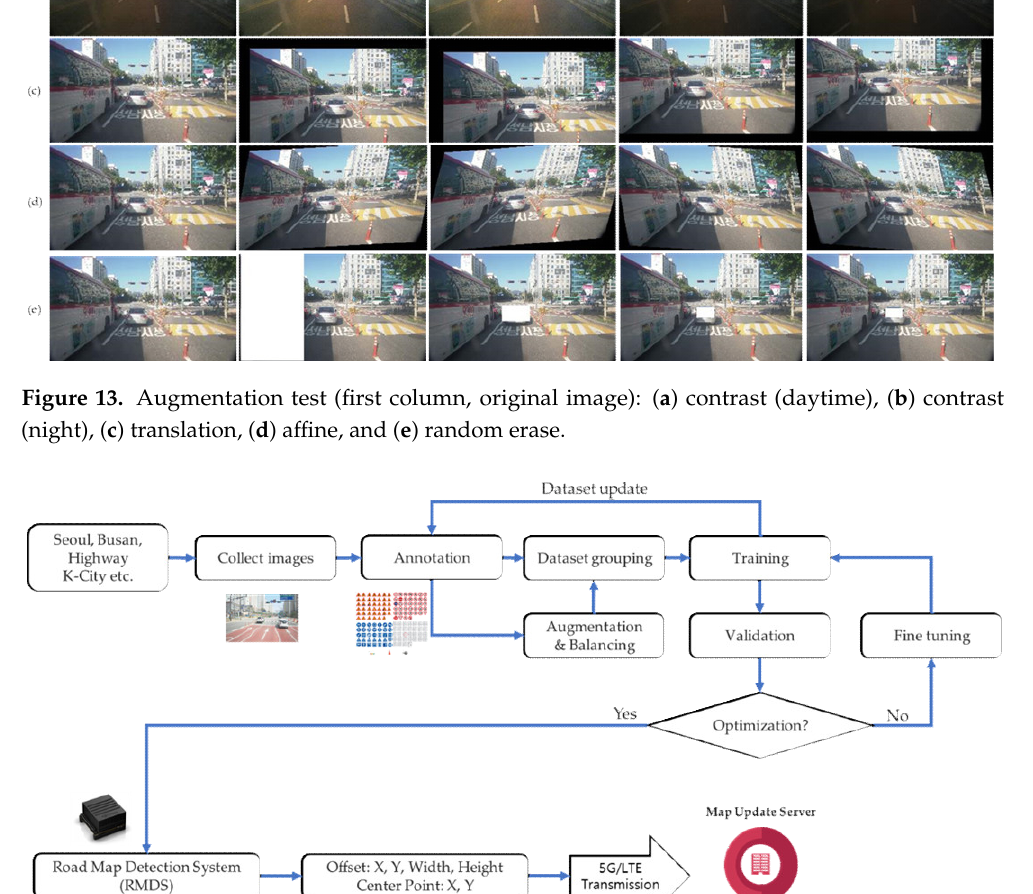
Figure 14. Flowchart of the process of sending the RMDS object detection result value (center point, detection area) to the update map server.